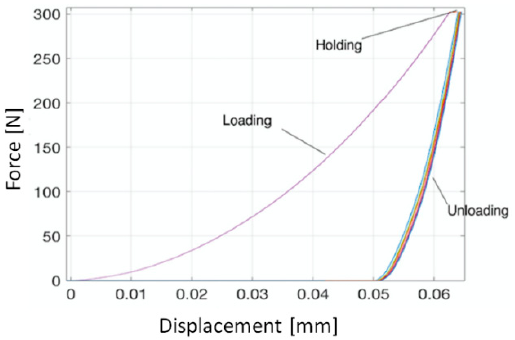
Figure 14. Typical macro-instrumented indentation load-displacement curves (four cycles in the same indent) at a 300 N peak load for the Ti-6Al-4V alloy.